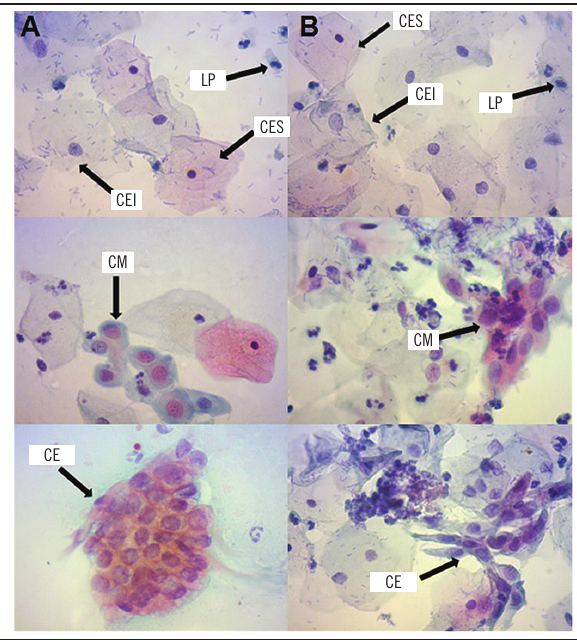
figura 3 − Fotomicrografias de tipos celulares observadas em amostras cervicais por exame de Papanicolaou (A) e preservadas em FIPLIQ após 15 dias (B). Papanicolaou, 400× FIPLIQ: fosfato de formaldeído-isopropanol; LP: leucócitos polimorfonucleares; CES: células escamosas superficiais; CEI: células escamosas intermediárias; CM: células metaplásicas; CE: células endocervicais.